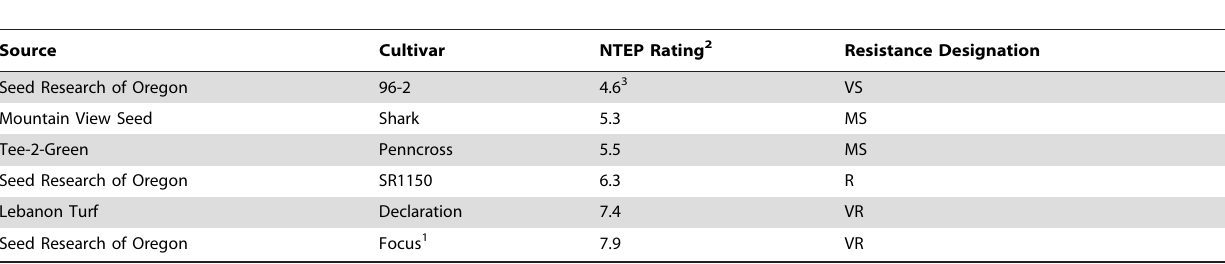
Table 2. Seed sources, cultivars, and National Turf Evaluation Program performance results for creeping bentgrass commercial seed lots used in S. homoeocarpa culture-based and molecular seed detection studies.